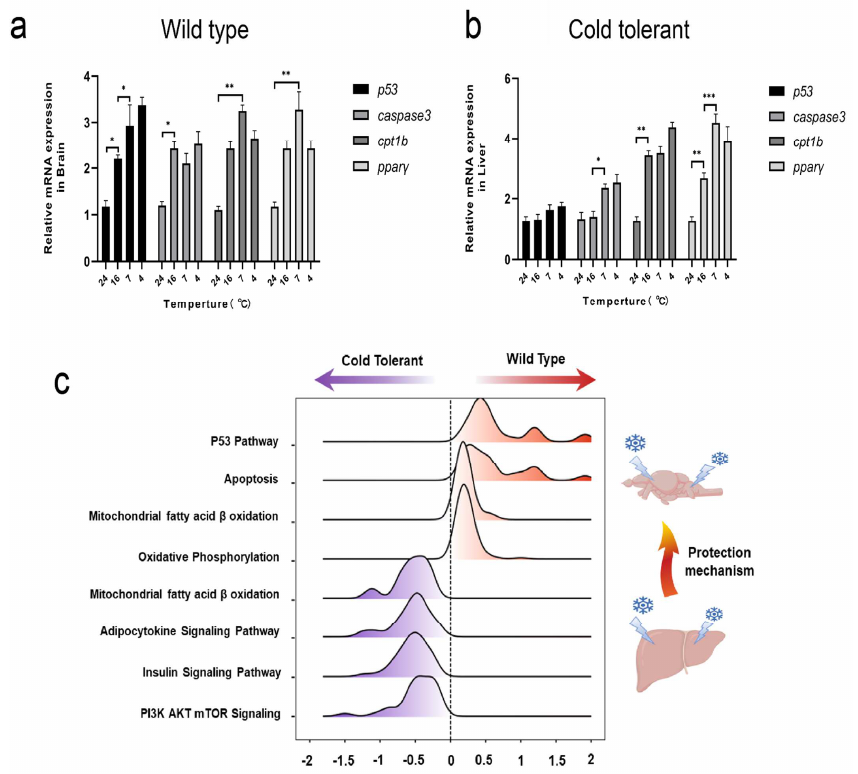
Figure 4. qRT-PCR and Gene Set Enrichment Analysis ridge plot for significant KEGG terms, dynamic changes in the balance of gene regulation in liver and brain as a strategy for cold-tolerant fugu to cope with cold stress. ( a ) qRT-PCR detection of the expression of p53 , caspase3 , cpt1b , pparγ genes in the brain of wild-type fugu. n = 4 biologically independent experiments. * p < 0.05, ** p <